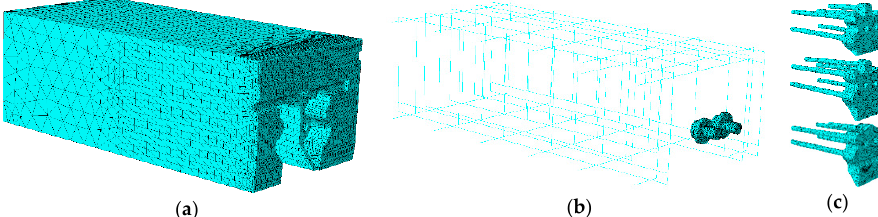
Figure 10. Joint 3D model: ( a ) one half of a concrete segment; ( b ) one half of the reinforcement cage, two halves of bolts, and two washers; ( c ) different DIJPs (Type-Bpos, Type-A, Type-Bneg).